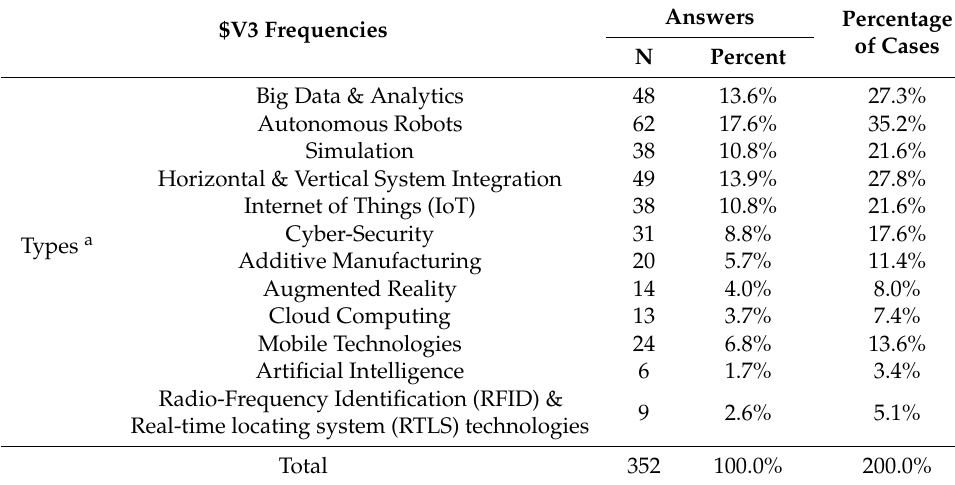
Table 3. Frequency table for multiple response analysis regarding future technology types implemented by Small and Medium-sized Enterprises (SMEs).